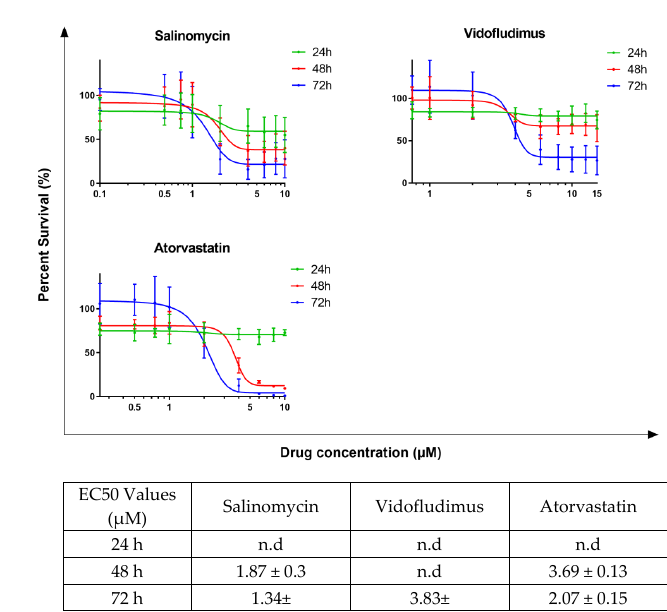
Figure 3. Candidate drug dose response assays for THP-1 cells in liquid culture. ( A ) Line graphs showing viability of THP-1 cells (as percentage survival) over time following candidate drug treat- ment at the indicated dosage as compared to 0.2% DMSO vehicle control. Mean values ± standard deviation of biological replicates (N = 4, n = 3) are plotted throughout. ( B ) Calculated EC50 values for each candidate drug at 24, 48, and 72 h following treatment.